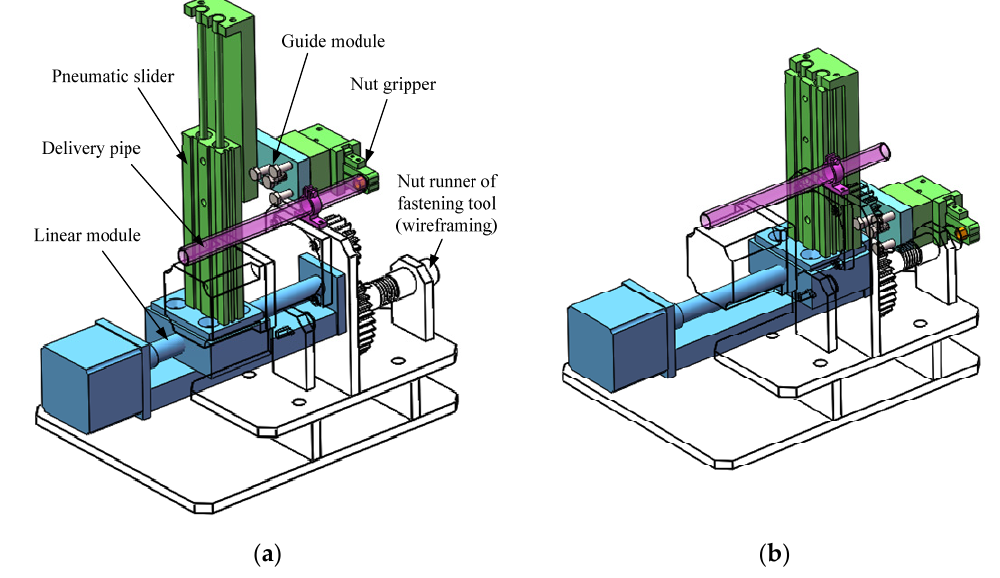
Figure 6. FA device, ( a ) state obtained the nut ( b ) state reached the alignment